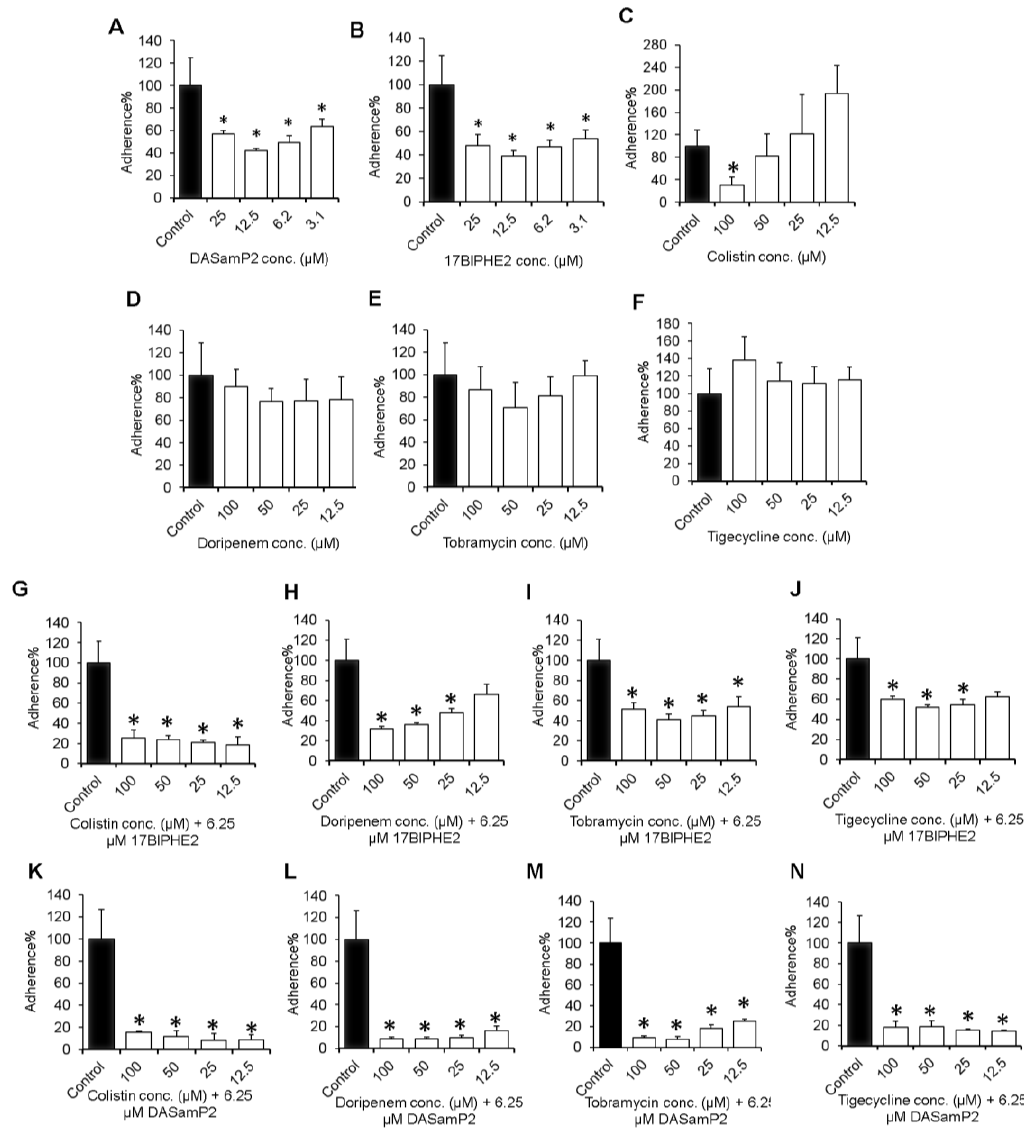
Figure 1. Inhibition of the attachment of P . aeruginosa PAO1 onto the polystyrene surfaces in the 96-well plate by peptides, antibiotics or their combinations. Shown are panels A – C representing peptide alone, D – F representing antibiotics alone, G – J are combination of antibiotics and 17BIPHE2 and K – N are combination of antibiotics and DASamP2, respectively. Attachment is the first step for biofilm formation. p values were calculated based on paired Student’s t -test with two tailed distribution and values <0.05 were considered significant (*)